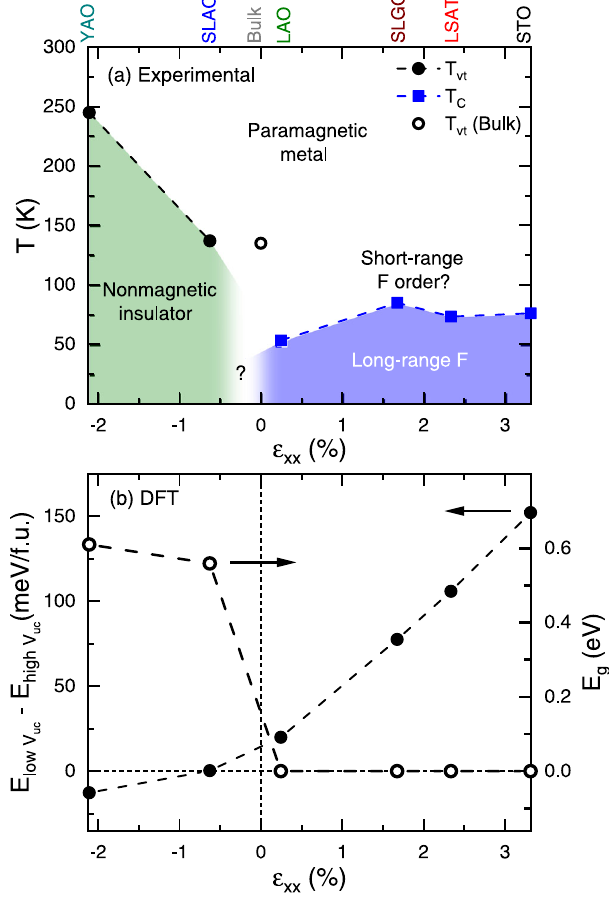
Fig.6|Strain “ phasediagram ” of(Pr 0.85 Y 0.15 ) 0.7 Ca 0.3 CoO 3- δ andDFTresults. ( a ) Experimental temperature ( T ) vs. “ in-plane strain ” ( ε xx ) phase diagram for (Pr 0.85 Y 0.15 ) 0.7 Ca 0.3 CoO 3- δ . Thin fi lm (solid points, ∼ 30-unit-cell-thick) and bulk (openpoint)dataareshown,withtherelevantsubstrateindicatedatthetop.(Note thatpartialstrainrelaxationoccursonSTO(seeFig.1(f,i),meaningthatthetrue ε xx value on that substrate only will be lower than shown). The valence transition temperature T vt (circles) and Curie temperature T C (squares) are plotted. Green, white, and blue phase fi elds indicate “ nonmagnetic insulator ” , “ paramagnetic metal ” , and “ long-range ferromagnet (F) ” , respectively. ( b ) Energy